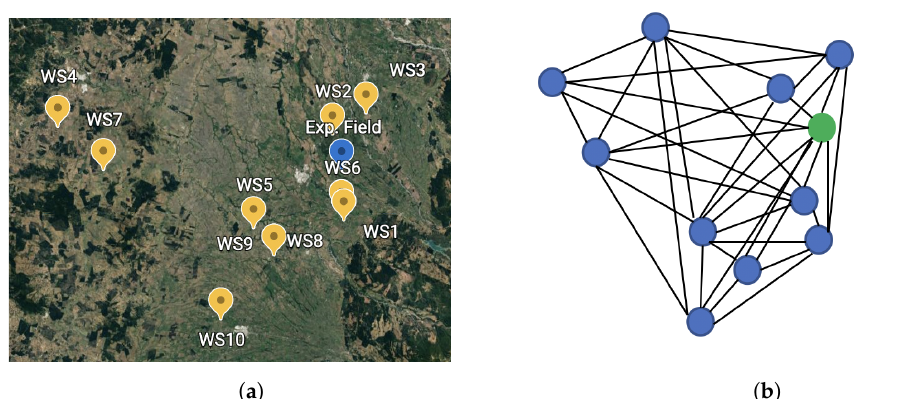
Figure 1. Graph modeling based on location of experimental site and weather stations. ( a ) Map of weather stations and experimental site; ( b ) Schematic version of a graph constructed at a single time step.